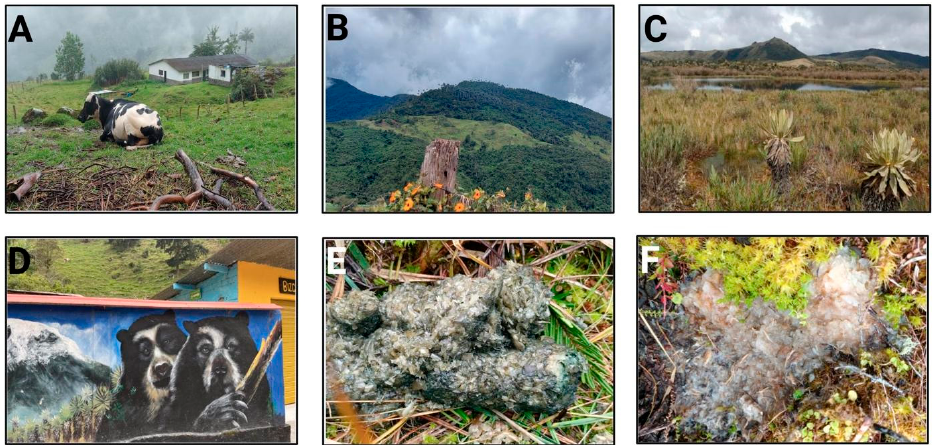
Figure 2. Cattle farms at the High altitude of Central Andean Mountain are located at the border of T. ornatus’ territory ( A – C ). Awareness-raising campaign to conserve the land of the Andean bear and protect its territories ( D ), Feces collected from T. ornatus ( E , F ).